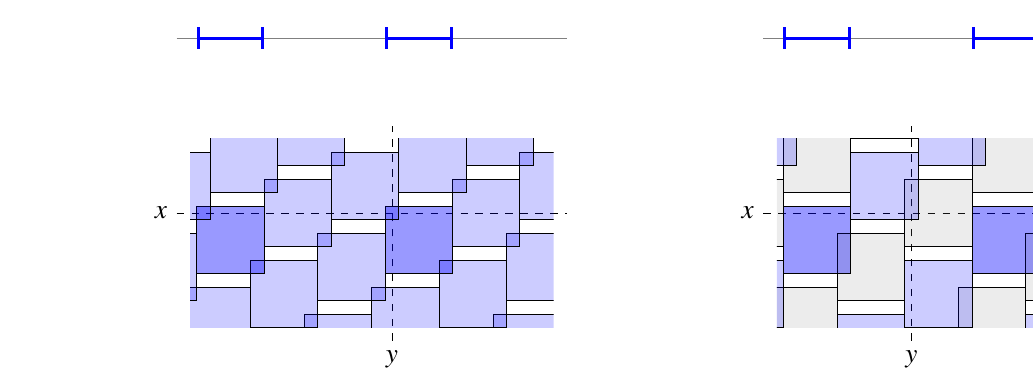
Figure 5: First case of Lemma 25, in the case (cid:96) = 3: auto-intersects. the set W k + 1 + (cid:101) Λ k + 1